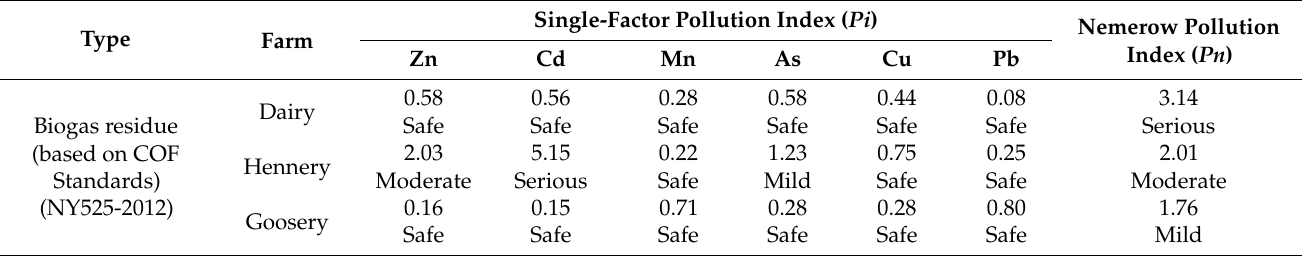
Table 3. Heavy metal pollution indices of biogas residues, biogas slurries, and sewage water from three different farm